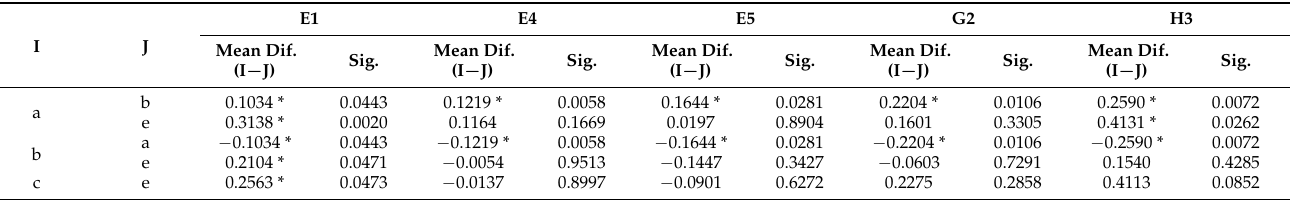
Table 4. Multiple comparison analysis of sensory perception indicators of riverside parks beside different river systems (only some important data are displayed here; all data can be found in the Supplementary File in the Supplementary